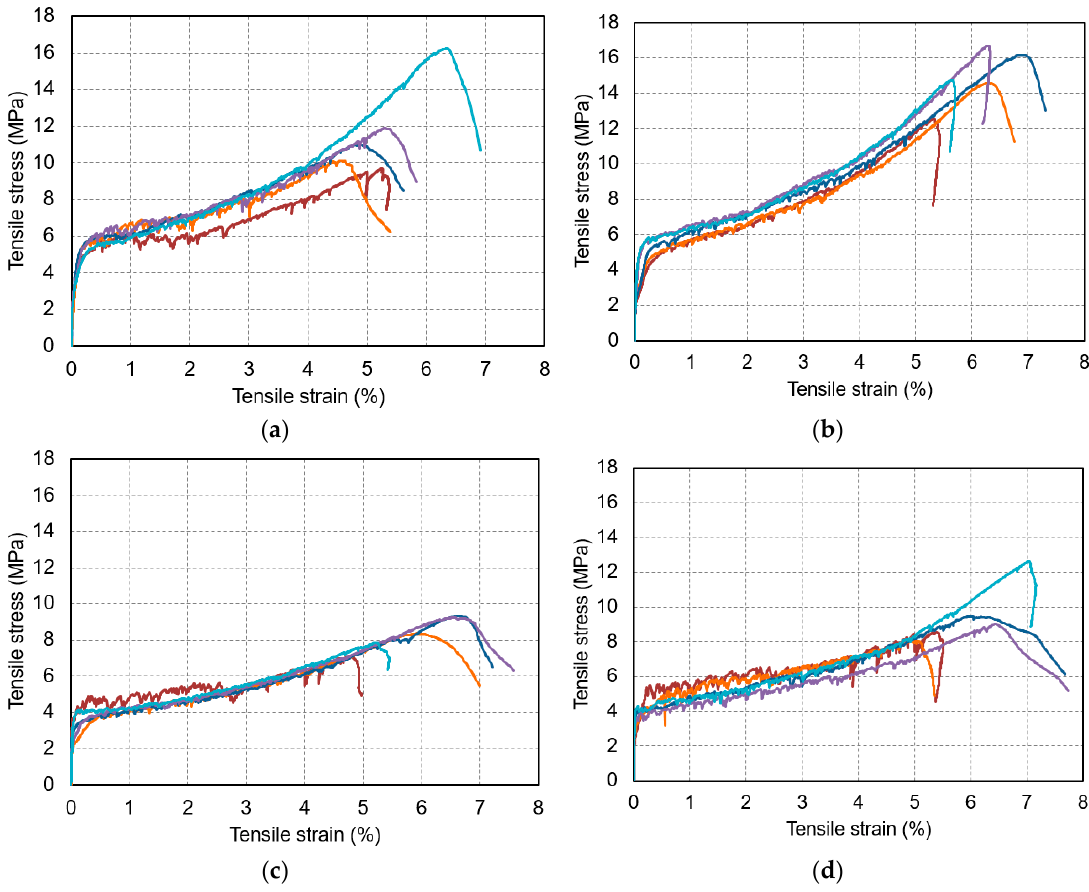
Figure 4. Tensile stress and strain curves: ( a ) W21-S0, ( b ) W21-S5, ( c ) W25-S5, and ( d ) W30-S5. Based on the fact that there was little decrease in stress, it can be inferred that the interfacial bond between the fiber and the matrix was high. Figure 5 shows the average tensile stress and strain curves of each mixture, which are expressed using a trilinear model. The W21-S5 mixture, which was prepared by replacing 5% of the binding materials of the reference mixture (W21-S0), exhibited a tensile strength and a tensile strain capacity that were much higher than the reference mixture. The experimental results indicated that the substitution of ZSF can improve both tensile strength and tensile strain capacity. In the mixtures prepared using 5% ZSF substitution, the tensile strength and the tensile strain capacity decreased as the water-to-binder ratio was